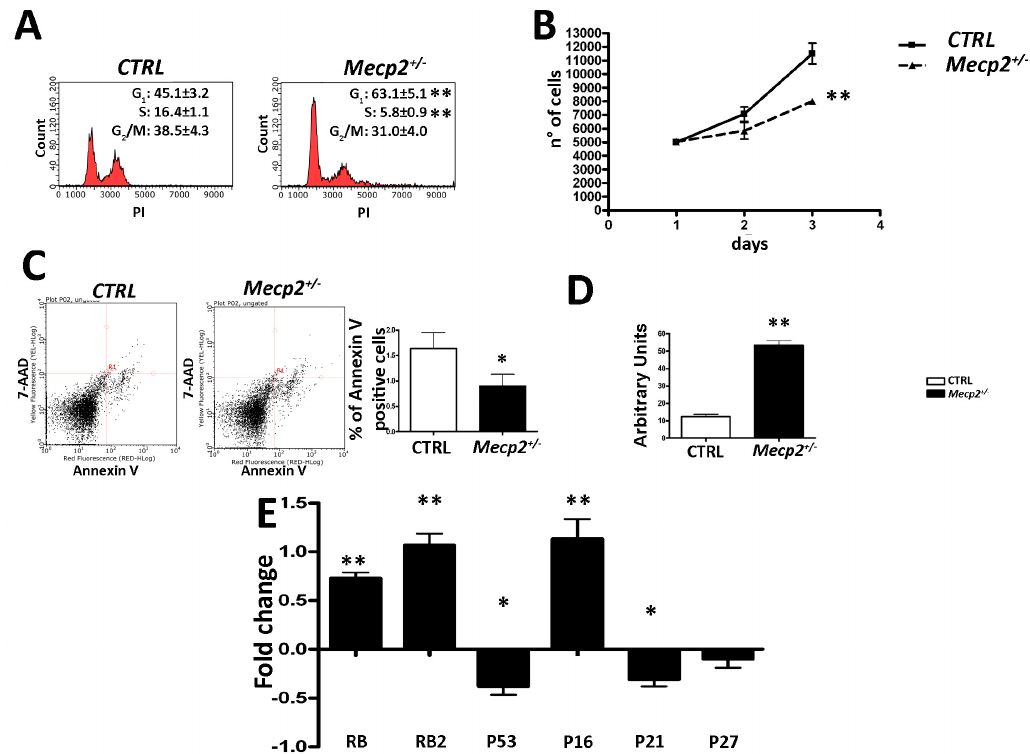
Figure 1. Cell growth, apoptosis, and senescence evaluation. ( A ) The picture shows the cell cycle profiles of the Mecp2 +/ − mesenchymal stromal (MSCs) and control (CTRL) cells ( ± SD, n = 5 biological replicates, ** p < 0.01). ( B ) Cell proliferation evaluation by the Quick Cell Proliferation Assay Kit II. At 1, 2, and 3 days post plating, the cells were collected and counted ( ± SD, n = 5 biological replicates, ** p < 0.01). ( C ) Apoptosis detection by the fluorescein conjugated Annexin V assay. Apoptotic cells were identified with Mecp2+/ − and CTRL MSCs. The graph shows mean expression values in the Mecp2+/ − and CTRL MSCs (±SD, n = 5 biological replicates, * p < 0.05). ( D ) Senescence analysis by the 4-methylumbelliferyl- β - D -